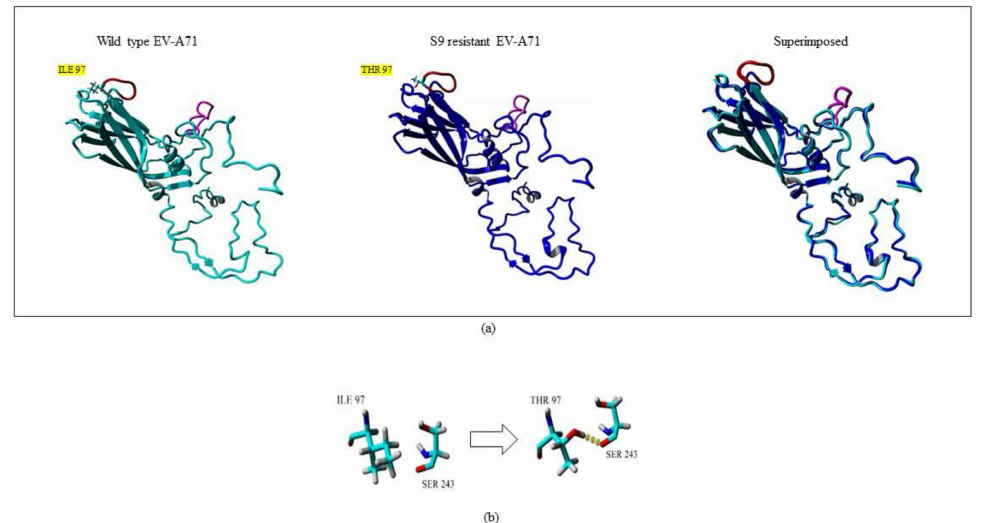
Figure 7. Superposition of wild type (WT) and silymarin-resistant mutant (S9) by YASARA v2020. ( a ) The cyan and blue structures represent WT and S9, respectively. The GH loop is shown in magenta while the BC loop is shown in red color. The amino acid mutation from isoleucine (I) in wild type to threonine (T) in the silymarin-resistant mutant in BC loop is highlighted in yellow. ( b ) A close-up view of the point mutation from amino acid isoleucine (I) in wild type to threonine (T) in the silymarin-resistant mutant (S9). The hydrogen bond observed is indicated as yellow dotted